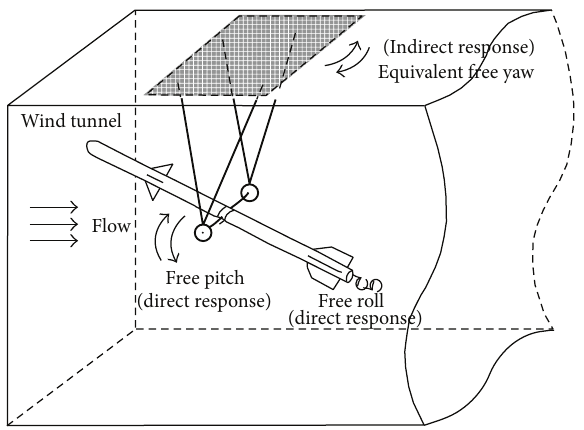
Figure 1: Illustration of direct and indirect response in VFT.